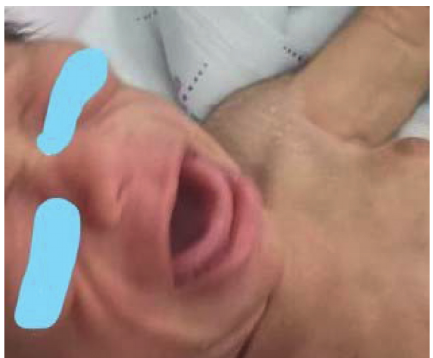
Figure 1: Macroglossia.